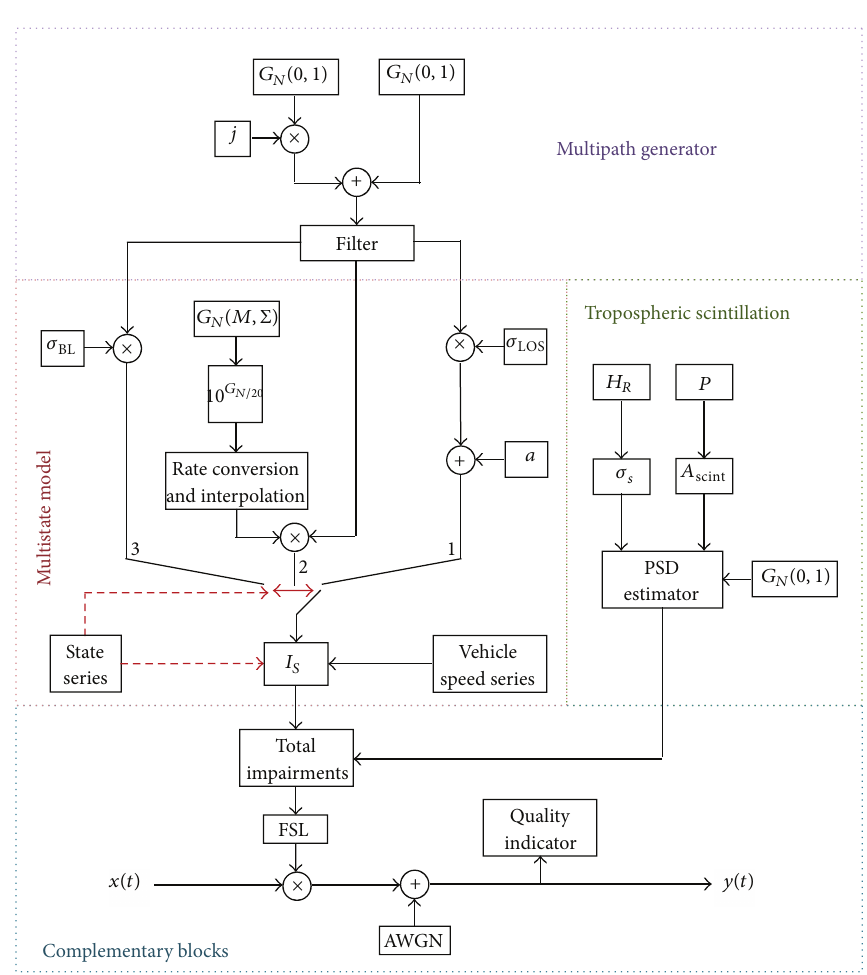
Figure 4: Proposed ELMSC